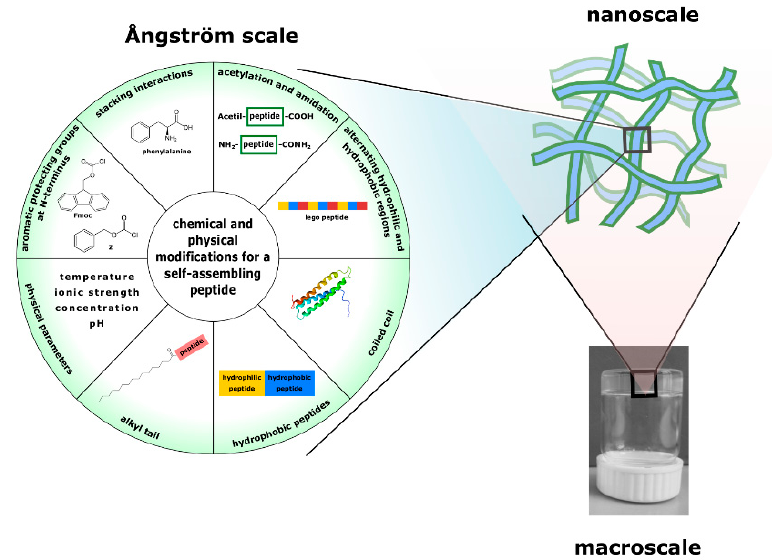
Figure 1. The appearance of a gel at various size scales. At the nanometric scale, the gel is a network of aggregates (usually fibers, tubes, etc.) that are formed thanks to spontaneous interactions among molecules (building blocks) of different nature. By changing chemically, the building blocks or the environmental parameters, the self-assembly can be controlled to obtain different on demand supramolecular